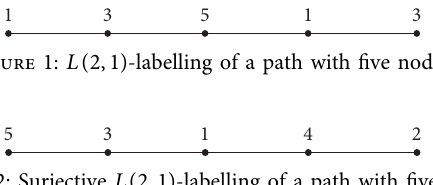
Figure 2: Surjective L ( 2 , 1 ) -labelling of a path with five nodes.